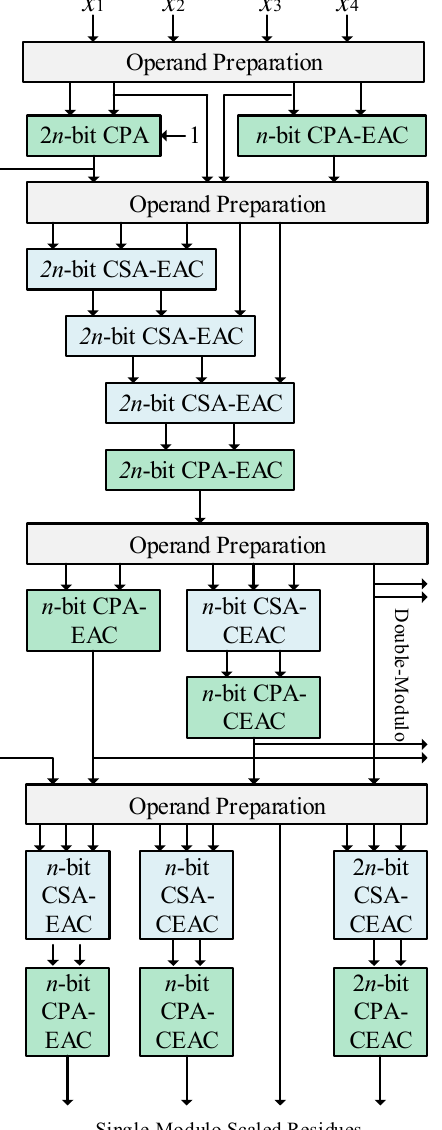
Figure 2. The proposed scaler for the moduli set {2 2 n + 1, 2 2 n , 2 n + 1, 2 n − 1} with scale coefficients (2 2 n + 1) 2 2 n and 2 2 n .